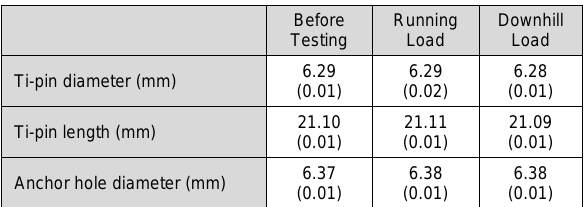
Table 1: Means and standard deviations (mm) of the original Ti-pin diameter, length, and anchor hole diameter dimensions. Dimensions are before testing, after running load, and after downhill walking load tests.